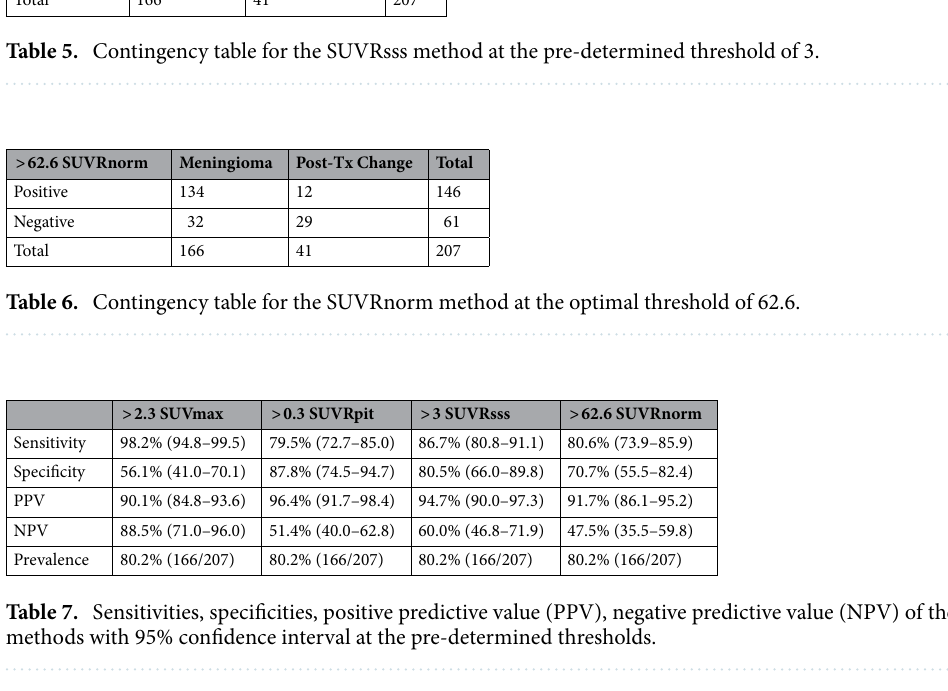
Table 7. Sensitivities, specificities, positive predictive value (PPV), negative predictive value (NPV) of the four methods with 95% confidence interval at the pre-determined thresholds.